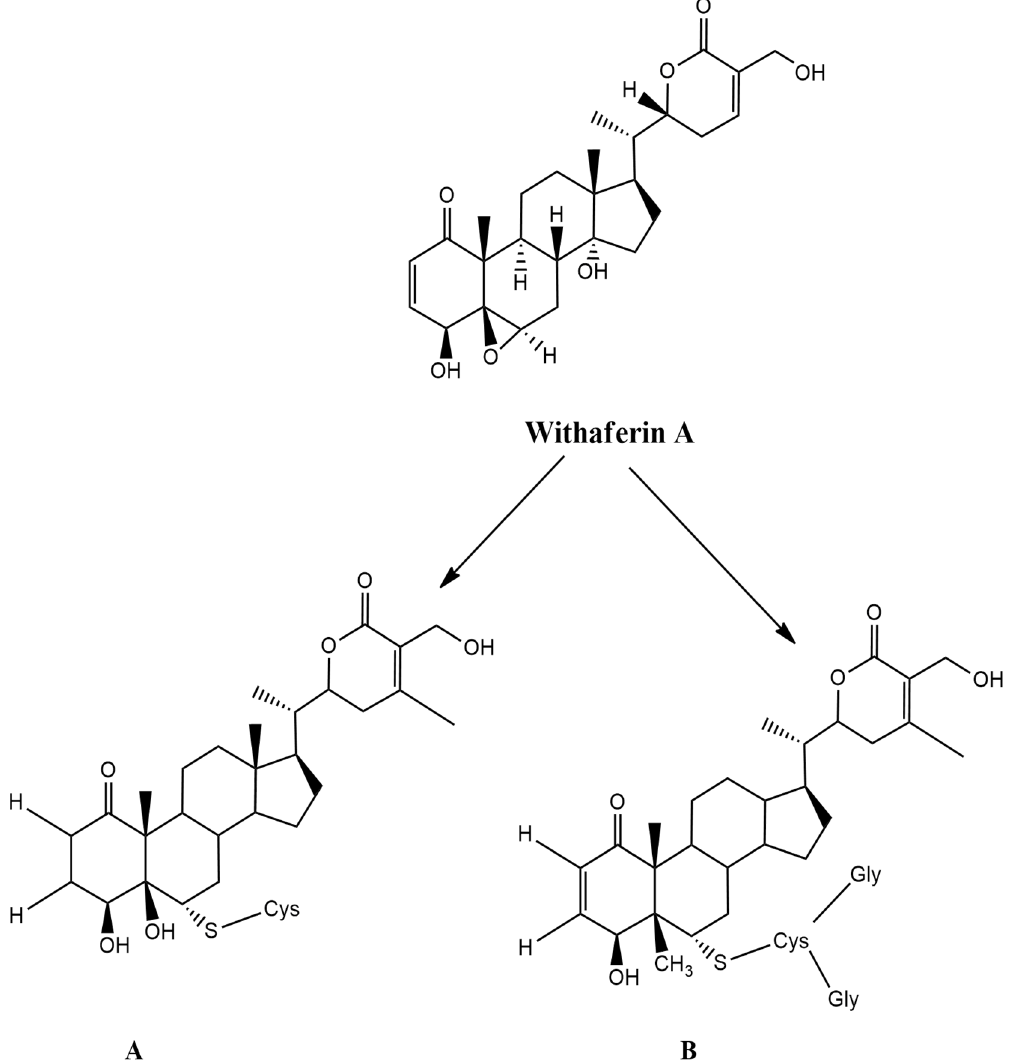
Figure 4. Metabolites of WA: ( A ) cysteine conjugate of WA; ( B ) glutathione conjugate of WA. Here, WA: withaferin A.